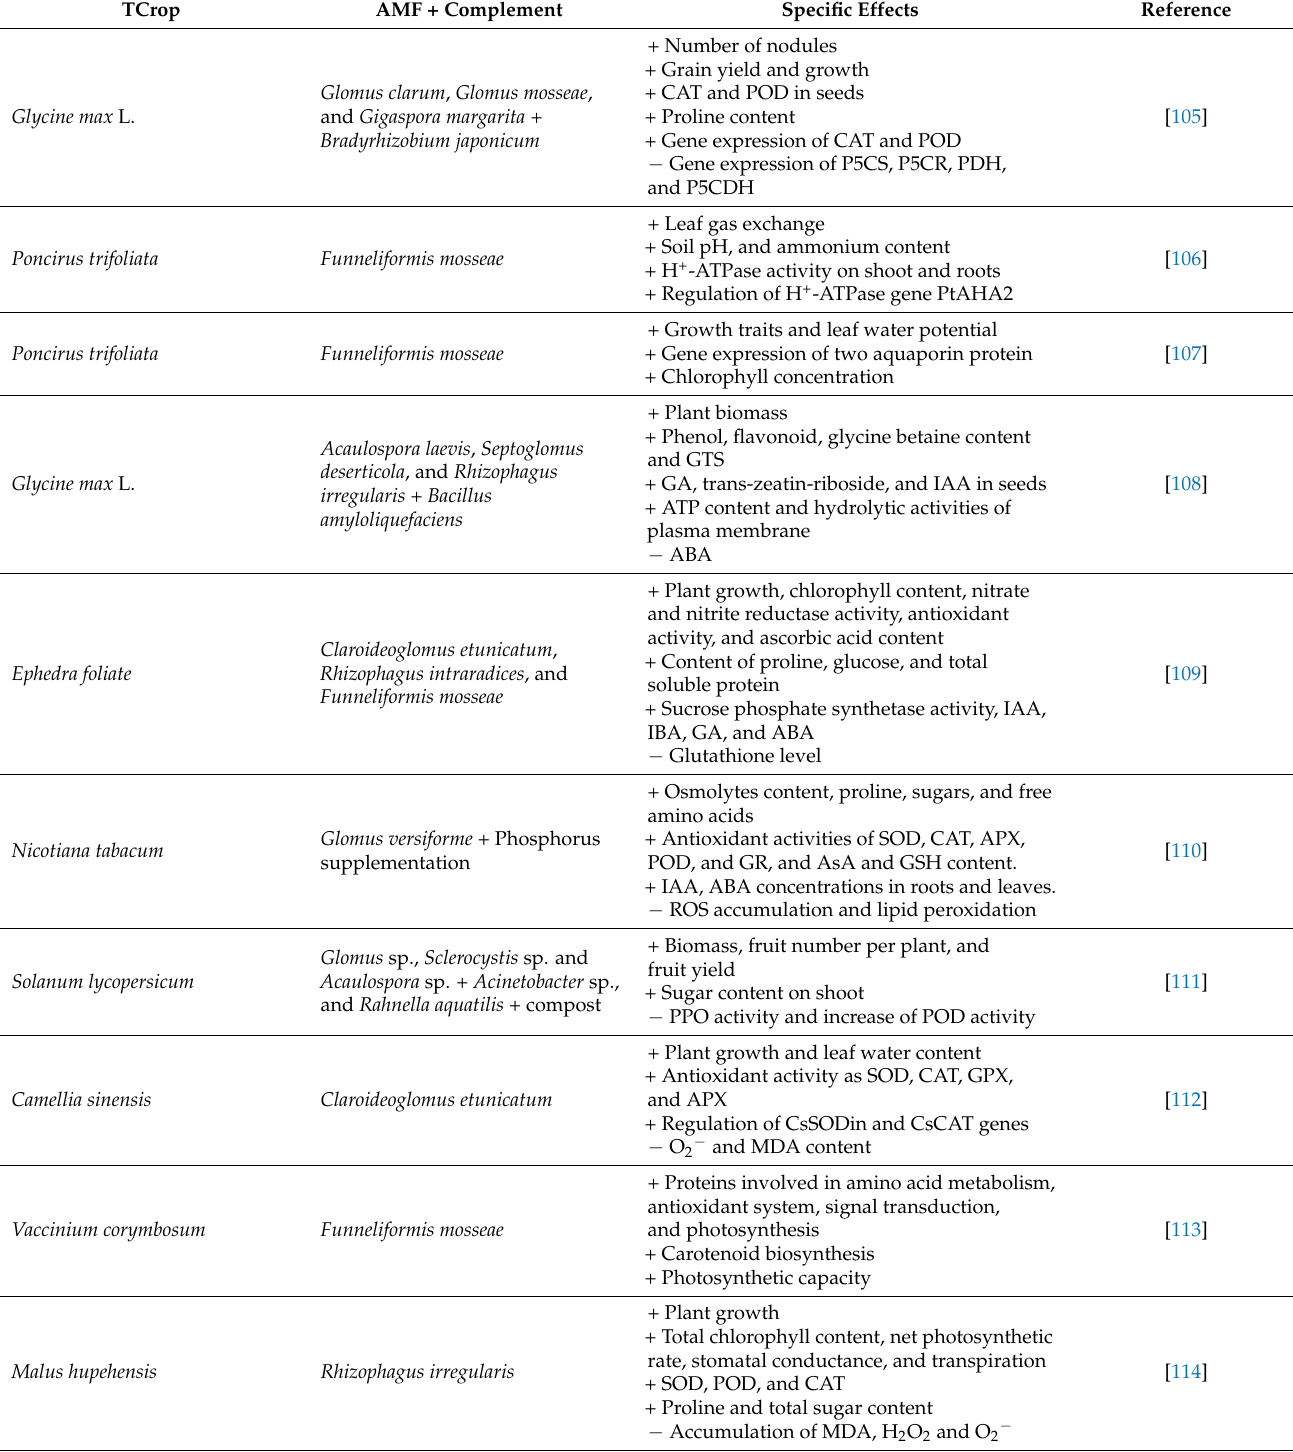
Table 2. Recent research (2020–2022) regarding the use of arbuscular mycorrhizal fungi (AMF) with or without complements and their effects on plant under drought